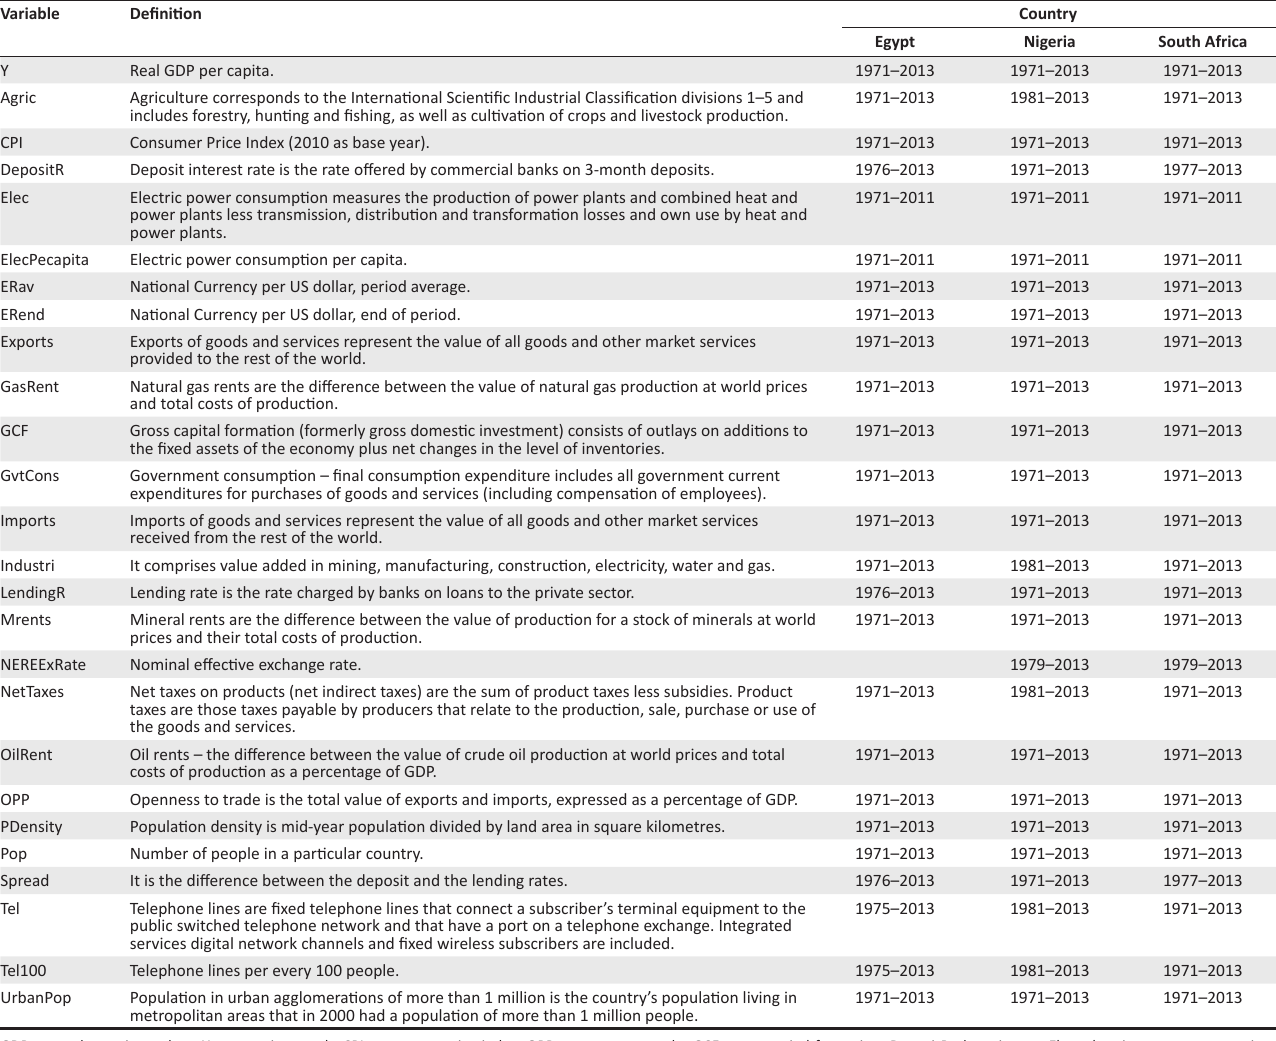
TABLE 1: Description of control